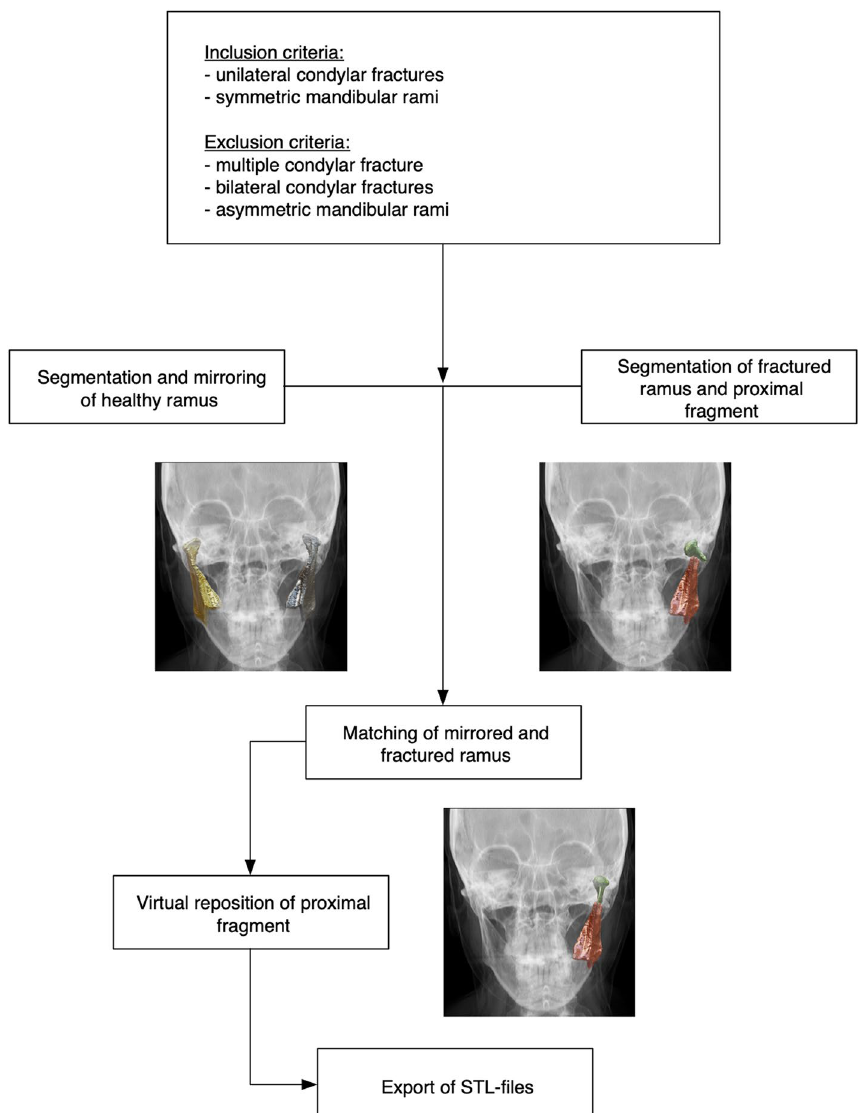
Fig. 4 Workflow for the creation of the